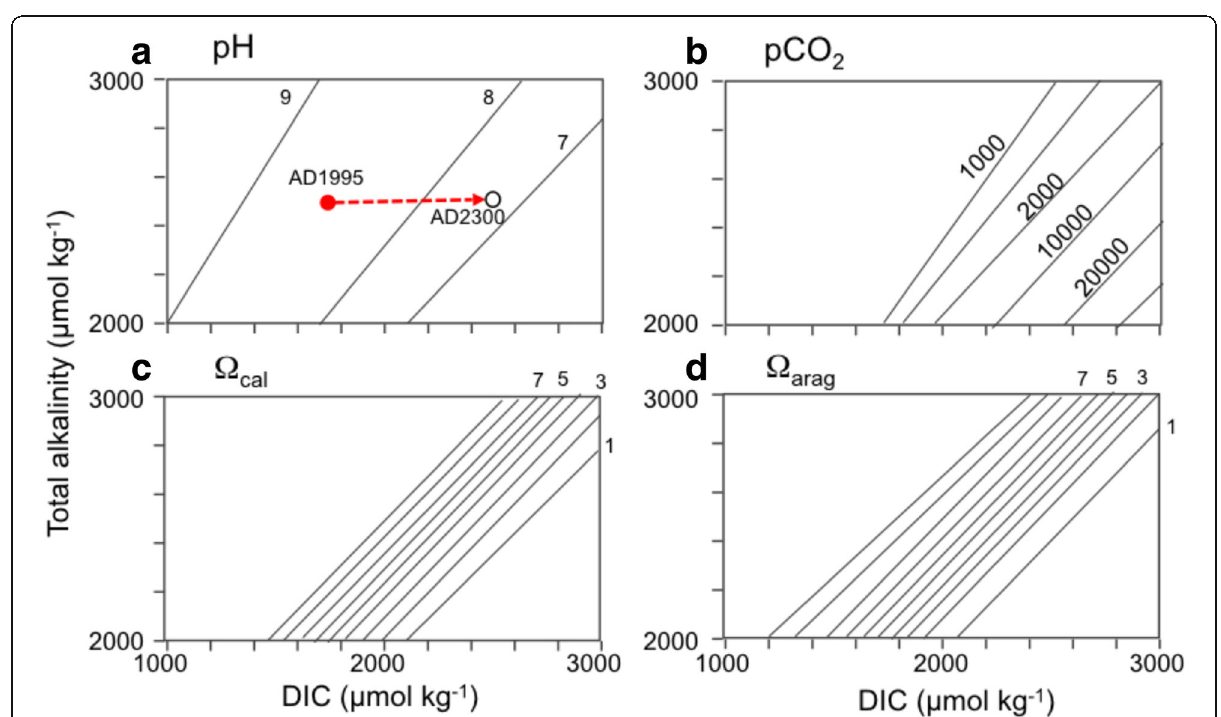
Fig. 2 Total alkalinity and dissolved inorganic carbon (DIC) diagrams showing contours of pH ( a ), partial pressure of CO2 ( b ), and saturation states of aragonite ( Ω arag; c ) and calcite ( Ω cal; d ). Chemistry of surface water under modern conditions (solid red circle) at St. 96 (5°00 ’ N, 144°55.7 ’ E; data are available from http://pacifica.pices.jp/table/) will be modified in 2300 AD (open